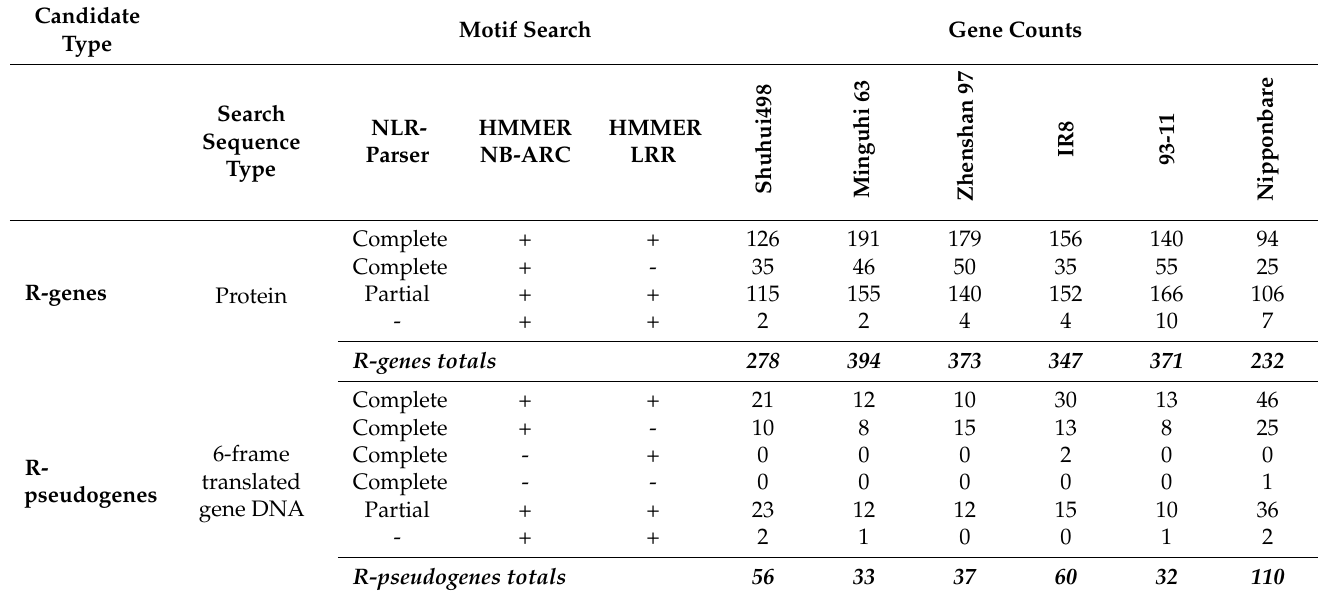
Table 2. Total number of candidate R-genes and R-pseudogenes identified by using both NLR-Parser and HMMER searches of the annotated protein sequences and 6-frame-translated gene DNA sequences in five indica reference genomes (Shuhui498, Minguhi 63, Zhenshan 97, IR8, and 93-11 [2013 assembly]) and Nipponbare ( japoinica